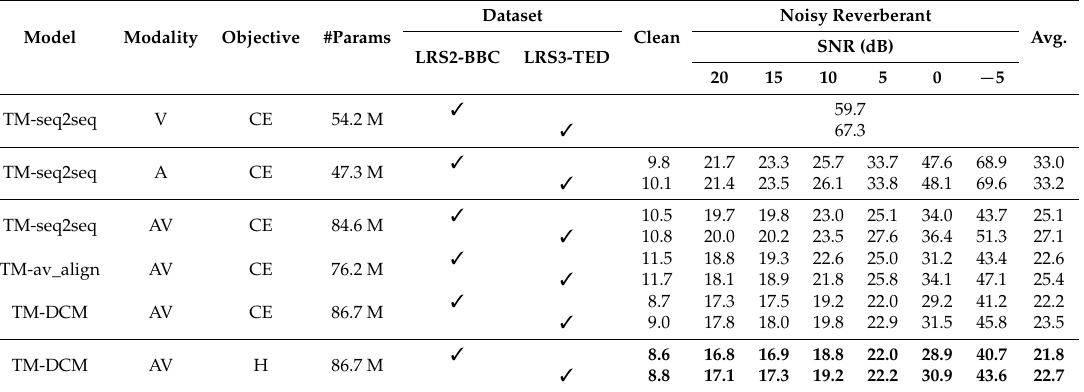
Table 1. Word error rates (WERs) (%) for the TM-seq2seq, TM-av_align, and TM-DCM on the LRS2-BBC and LRS3-TED datasets. The boldface WERs denote the best performance in each condition. Abbreviation to understand the table: A, audio-only modality; V, video-only modality; AV, audio–visual modalities; CE, cross-entropy loss only; H, hybrid CTC/attention loss; As a result that the video-only modality case (V) does not use the audio modality, we have a constant WER for each dataset on the TM-seq2seq using the video-only modality in the first two rows.